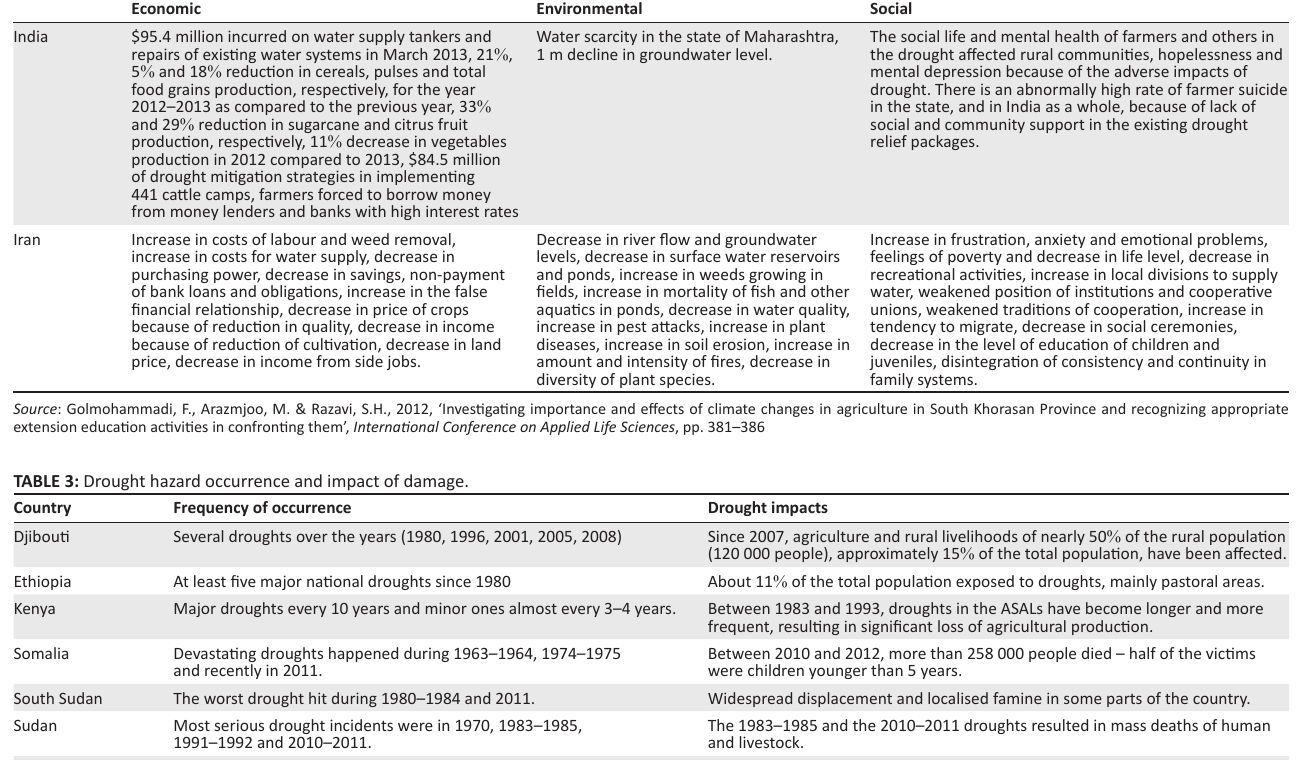
TABLE 2: Impacts of drought in Asian countries. Country